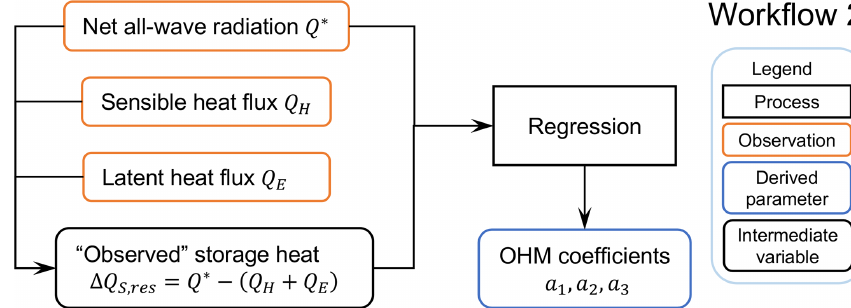
Figure 6. Workflow 2 (Fig. 1) to derive OHM coefficients. Related notebooks are provided in Sun et al. (2021). Table 6. As Table 5, but for OHM-related parameters (Sect. 4.2). See Fig. 7 for comparison and Table C2 for site-specific